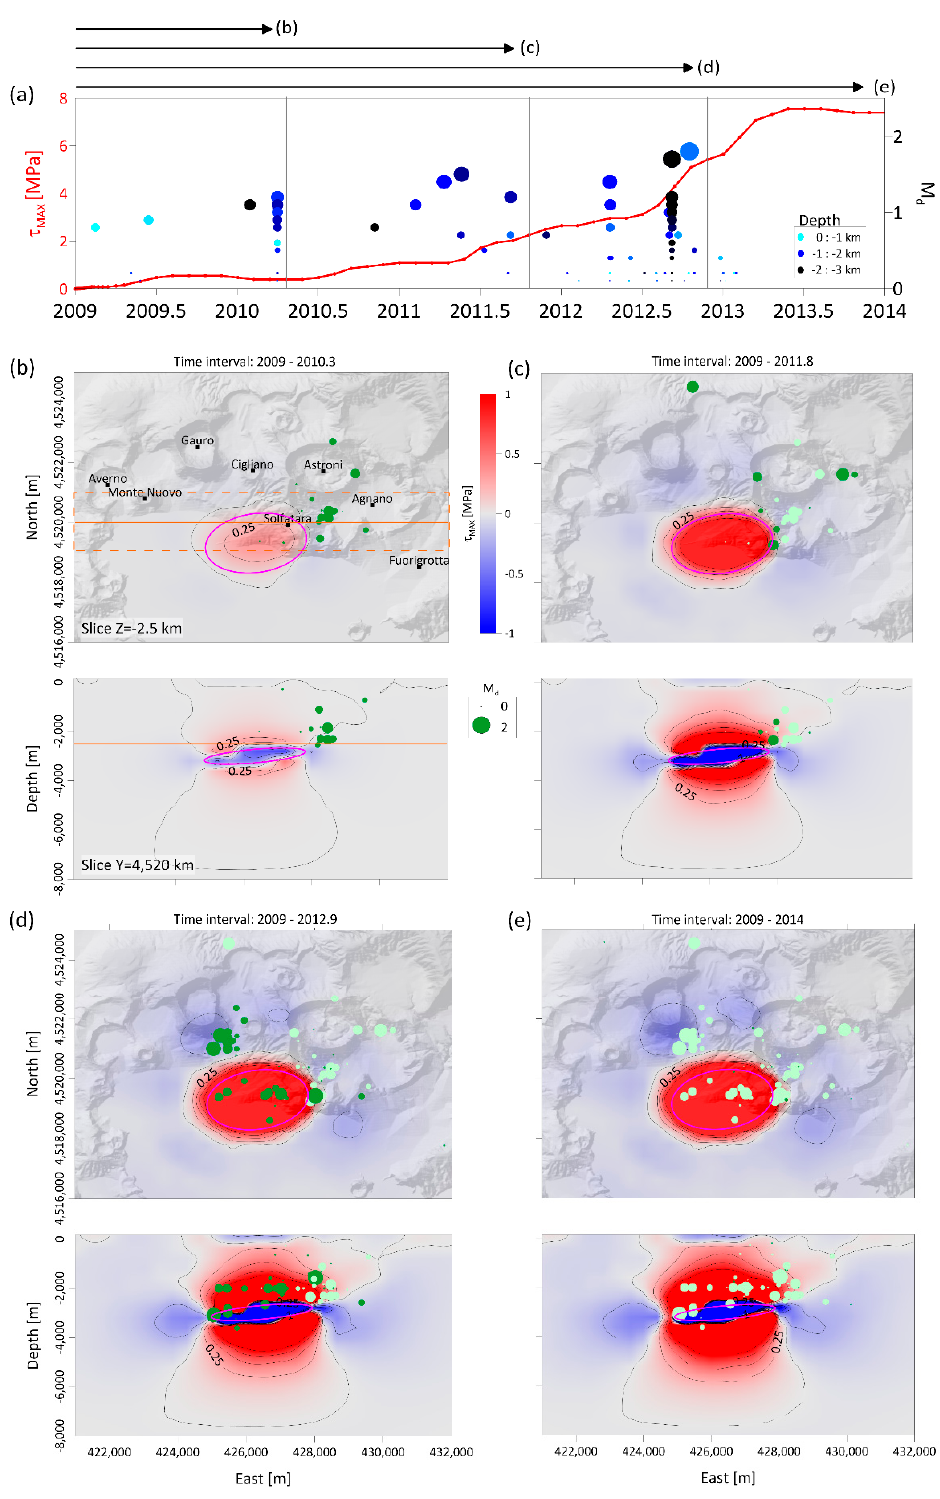
Figure 10. Shear stress analysis. ( a ) The 2009–2013 time series of modeled τ MAX at point (E = 426 km; N = 4520 km; Z = − 2.5 km); the CF caldera seismicity history, represented by circles with different color (depth) and size (magnitude), is superimposed. ( b – e ) Stress field evolution and earthquake distribution with M > 0 related to four time periods: ( b ) 2009–2010.3; ( c ) 2009–2011.8; ( d ) 2009–2012.9; ( e ) 2009–2014. The dark green circles indicate the successive earthquakes with respect to the previous ones (light green). The orange lines represent the locations of the vertical and horizontal sections. In these cross-sections, only the seismic events that fall within the dashed rectangle (buffer ± 1 km) in panel ( b ) are